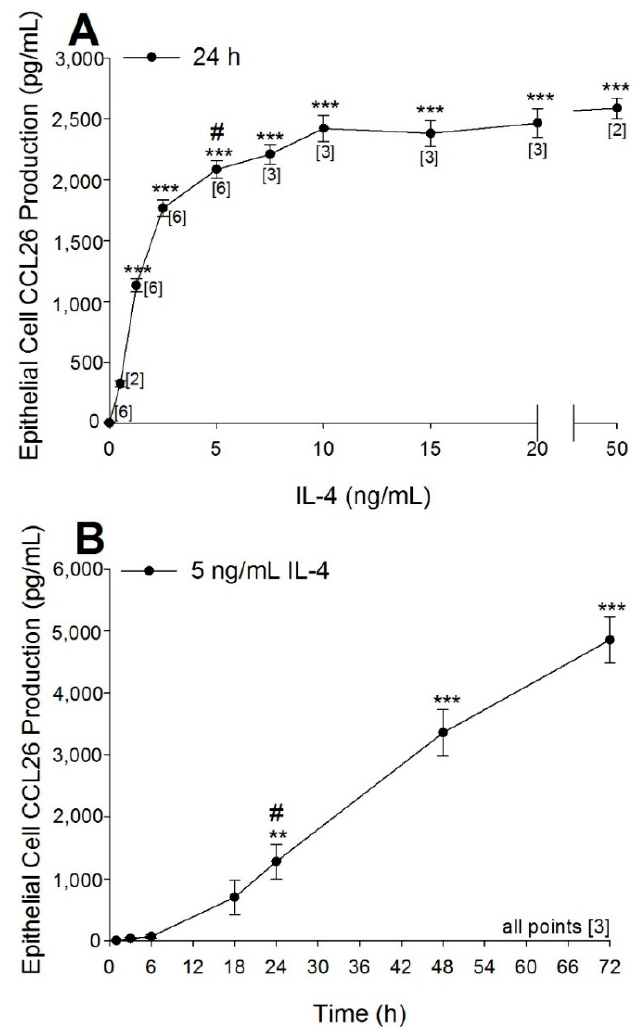
Figure 2. Optimization of IL-4 (interleukin-4) concentration and time for inducing CCL26 (eotaxin-3) production from A549 human lung alveolar epithelial cells. A549 cells were seeded at 5 × 10 5 in 12-well plates, serum starved for 24 h and incubated with ( A ) 0.5–50 ng/mL IL-4 for 24 h or ( B ) 5 ng/mL IL-4 for 1–72 h. Collected supernatants were measured for CCL26 by ELISA. The results are expressed as mean ± SEM, which were from 2–6 separate experiments and 6–18 individual measurements. Brackets, [ n ], indicate number of experiments for each data point. # indicates the chosen optimized dose or time for inducing CCL26 production. ** p < 0.01, *** p < 0.001.